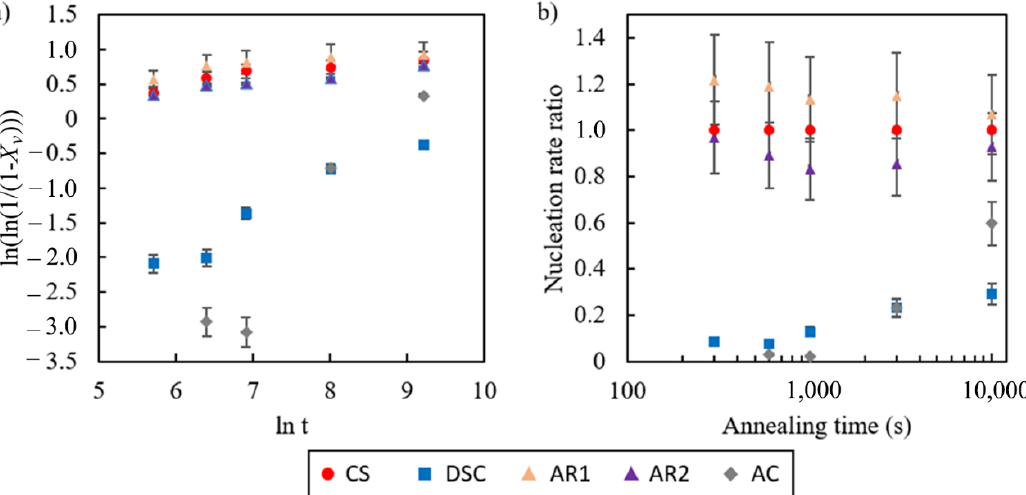
Figure 8. ( a ) JMAK plot and ( b ) nucleation rate ratio with respect to annealing time. (CS = commercial steel, DSC = simulated direct strip cast steel, AR1 and AR2 = austenite refined specimens from secondary heat treatment, AC = austenite coarsened specimen from secondary heat treatment). Note that some error bars are smaller than the height of the datum points, and cannot be seen.